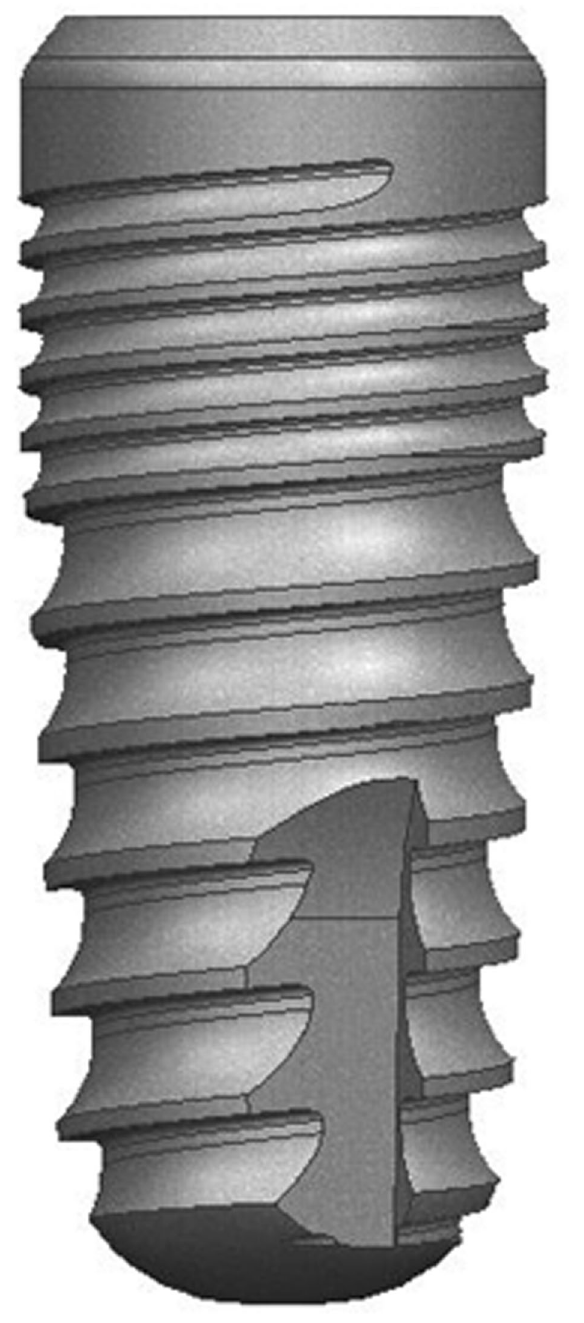
Fig. 1 Schematic drawing of the dental implant: 11-degree tapered and bone level (BioIn fi nity, Avrupa Implant Sanayi ve D ı ş Ticaret Ltd., Istanbul, Turkey)